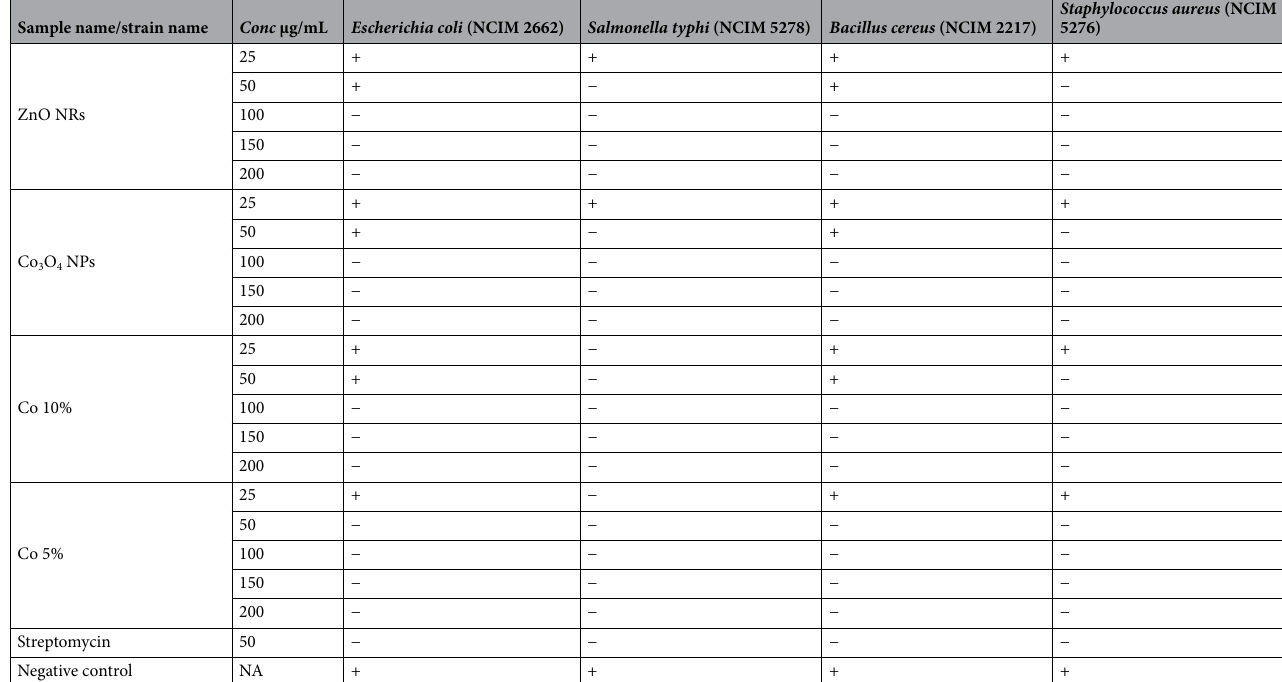
Table 3. Tabular representation of bacterial growth observed in different concentrations of ZnO NRs, Co 3 O 4 NPs, Co 10%, and Co 5% nanocomposite after 24 h. Positive (+): turbidity in the medium due to growth of microbes, negative (−): turbidity does not occur in the medium due to no visible growth. NA- does not contain any sample.